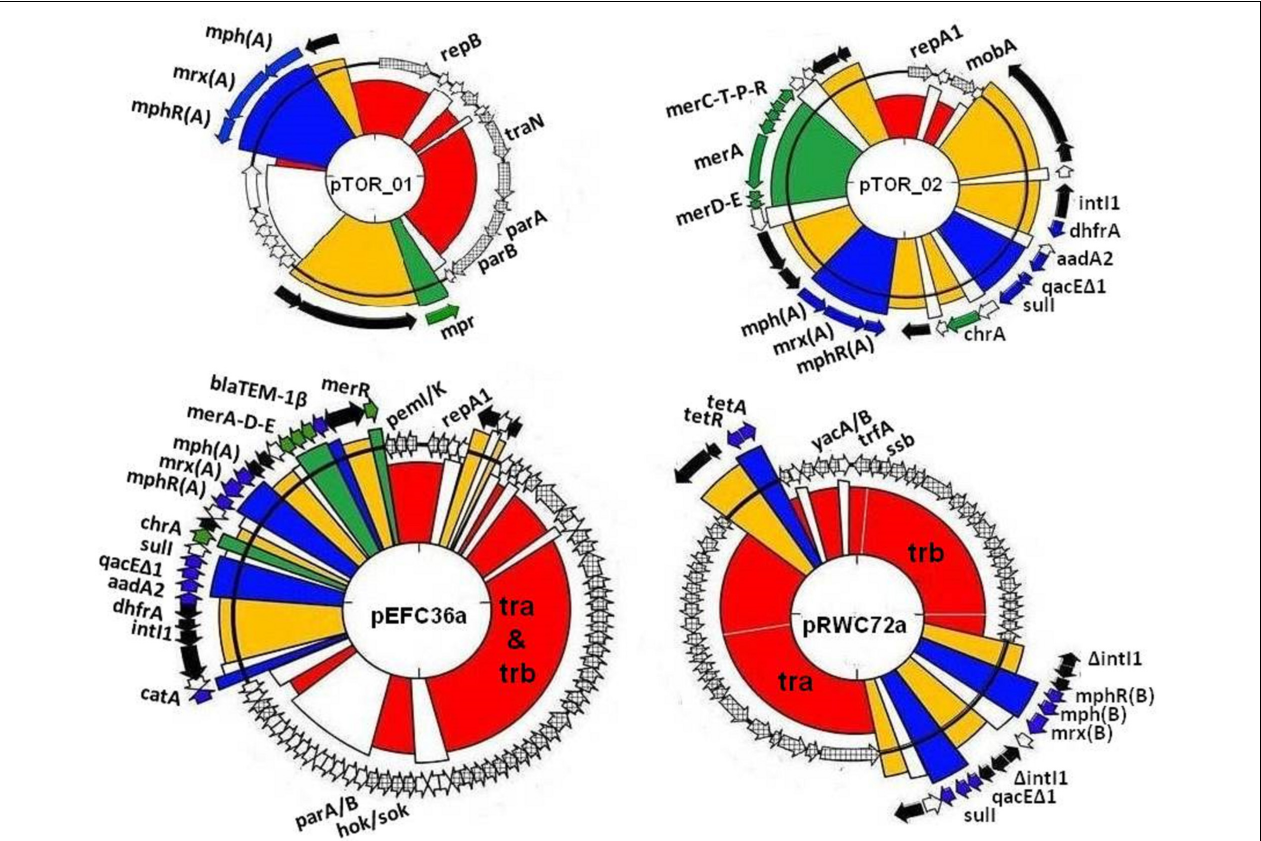
FIGURE 1 | Visual maps of multiple resistance plasmids; pTOR_01 (20,914 bp), pTOR_02 (28,080 bp), pEFC36a (87,419 bp), and pRWC72a (61,919 bp) showing mosaic features of resistance genes inserted in plasmid genetic backbones. The different colors represent regions